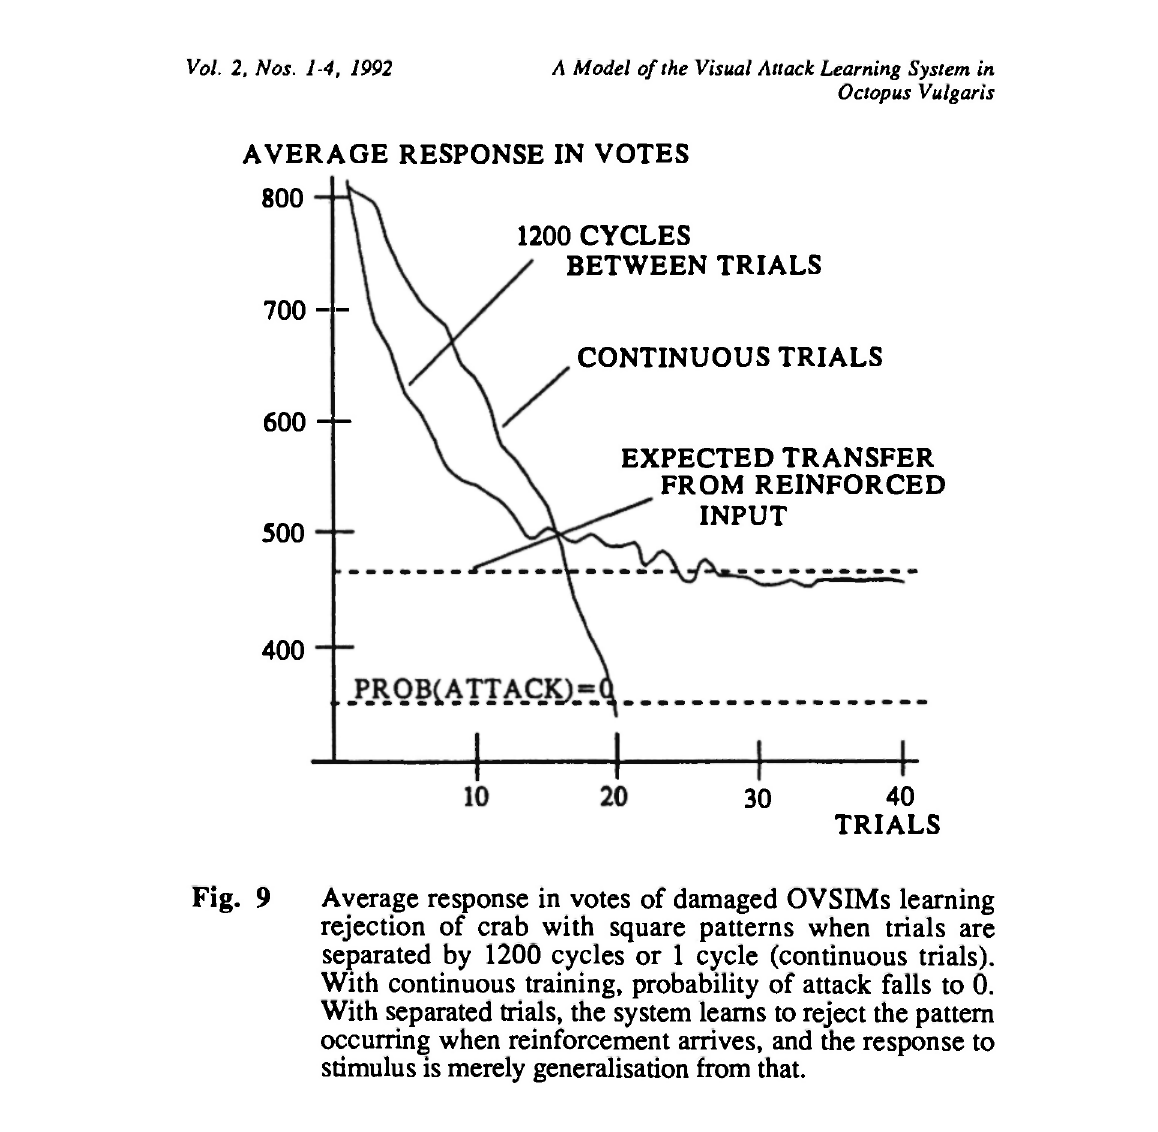
Fig. 9 Average response in votes of damaged OVSIMs learning rejection of crab with square patterns when trials are separated by 1200 cycles or 1 cycle (continuous trials). With continuous training, probability of attack falls to 0. With separated trials, the system learns to reject the pattern occurring when reinforcement arrives, and die response to stimulus is merely generalisation from